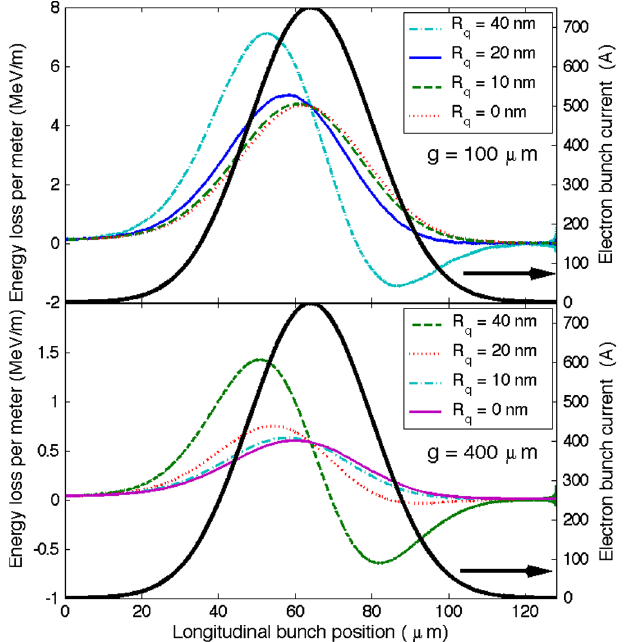
FIG. 19. Longitudinal wakefield for a 100 pC Gaussian elec- tron bunch between two parallel aluminum plates separated by g ¼ 100 (cid:1) m (top) and g ¼ 400 (cid:1) m